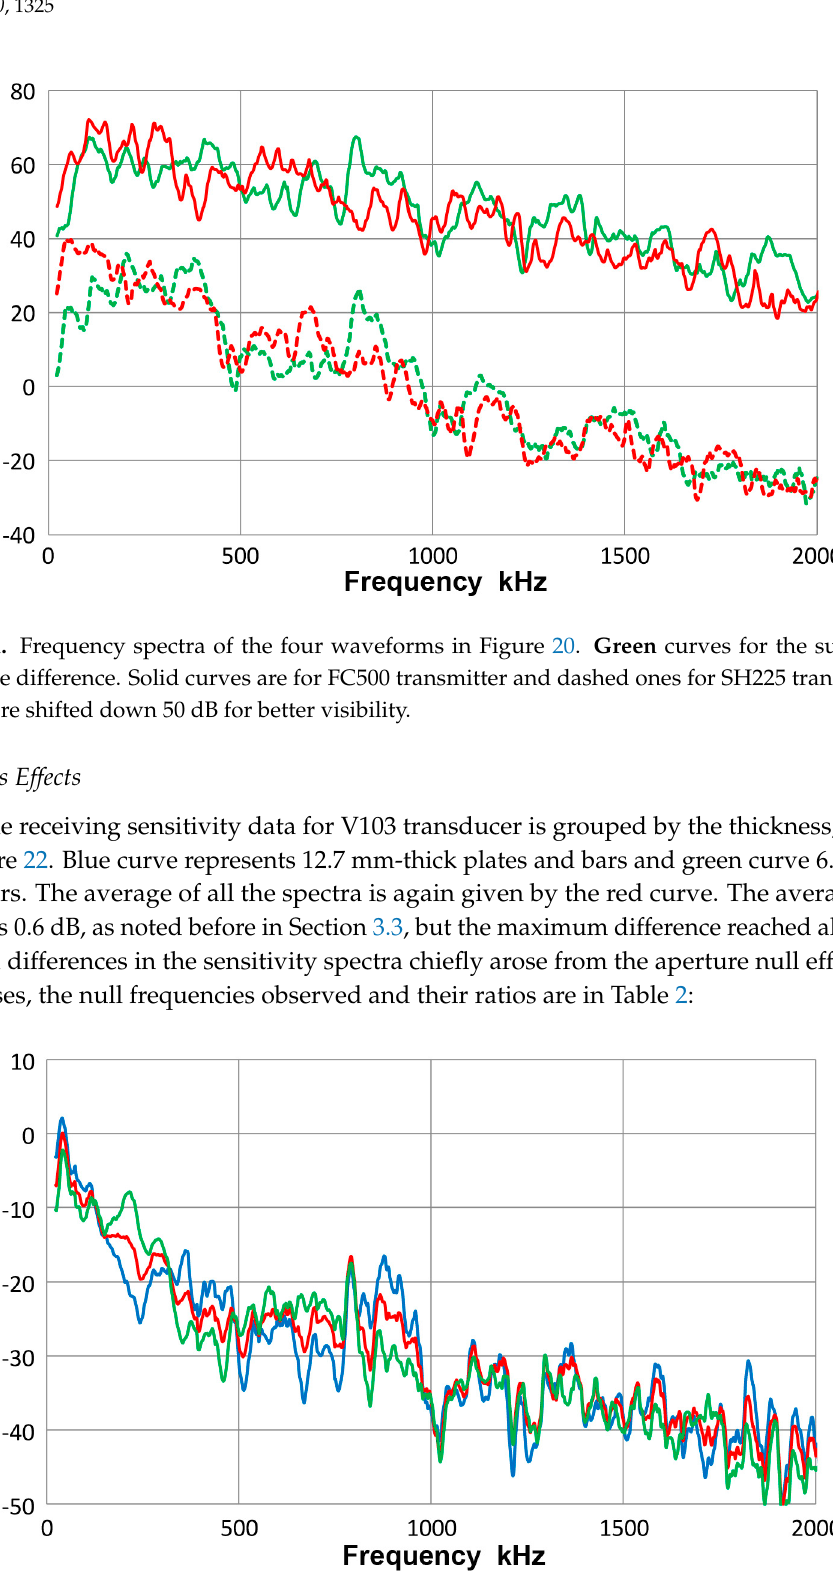
Figure 22. Receiving sensitivity of Olympus V103 transducer. Red -averaged guided wave sensitivity, blue -Lamb and bar waves from 12.7 mm-thick plate and bar, green -Lamb and bar waves from 6.4 mm-thick plate and bar.